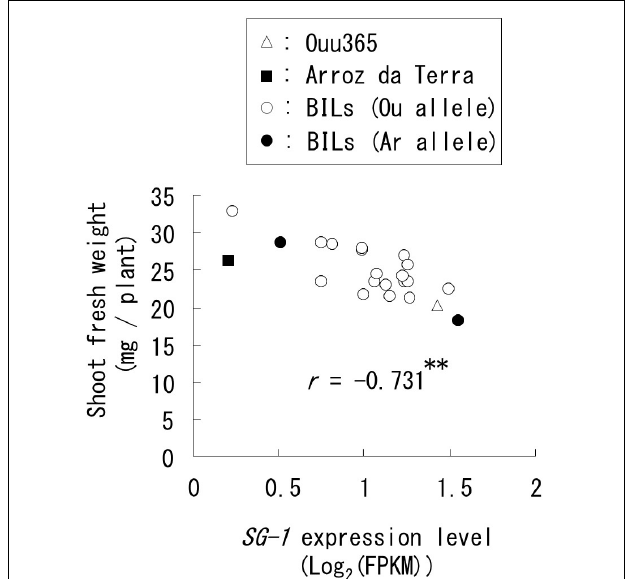
FIGURE 5 | Relationships between short grain 1 ( SG1 ) expression and shoot fresh weight in the lines used for RNA sequencing. Each symbol indicates the parental cultivars and BILs that have the Ouu365 (Ou) or Arroz da Terra (Ar) allele in the upstream region ( − 1948 bp) from the translational start site of SG1 . The r -value indicates the correlation coefficient; ∗∗ P = 0.00011 ( n =